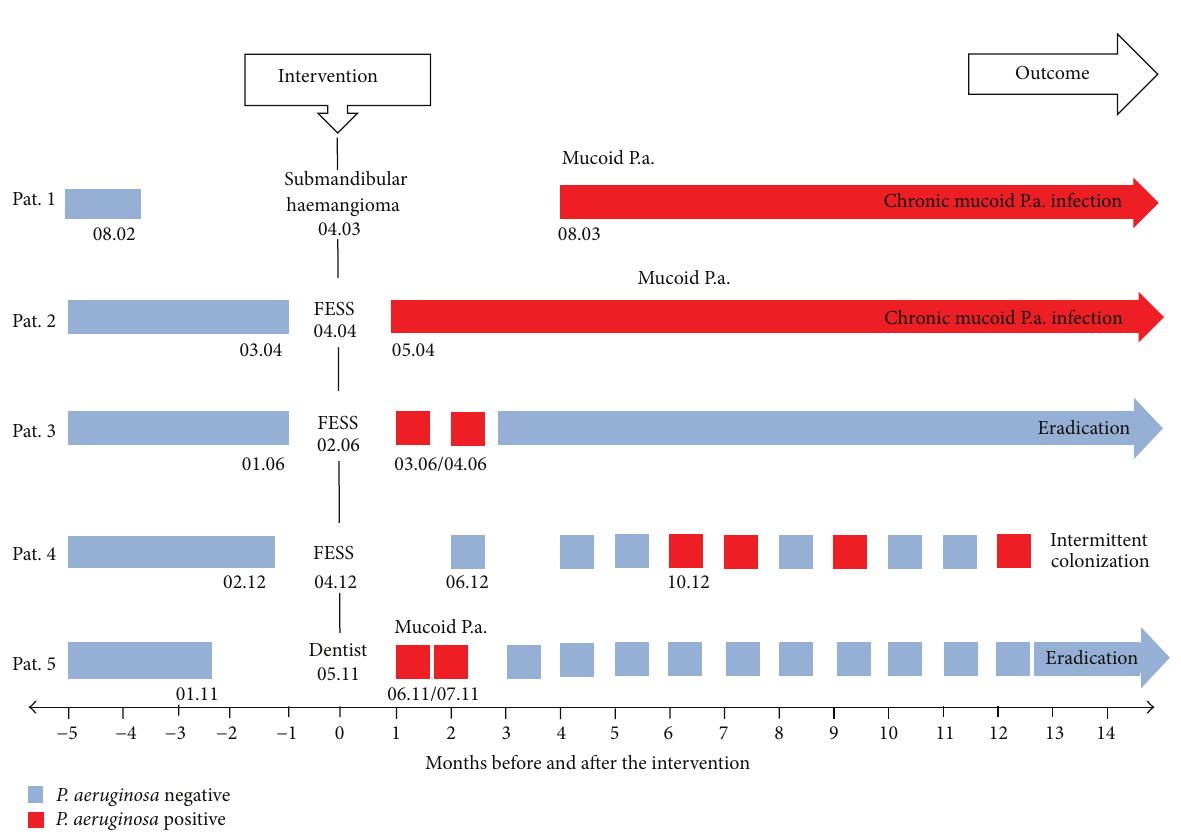
13 years, he suffered from chronic rhinosinusitis symptoms with impaired sense of smelling. In February 2006, at the age of 15, the patient (at that time, treated in another